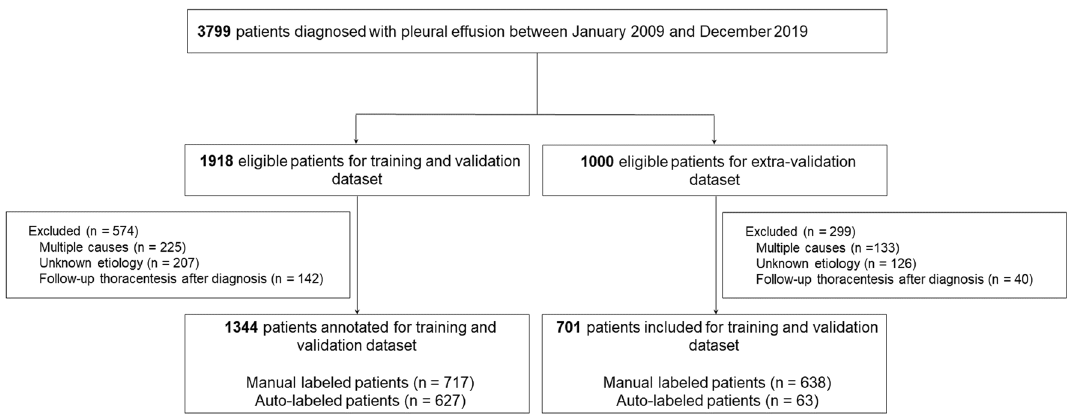
Figure 1. Patient flowchart. Top-1 accuracy Top-2 accuracy Micro-AUROC Weighted-AUROC Validation